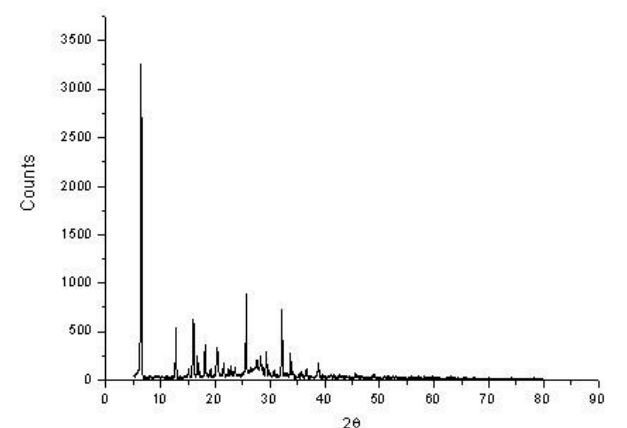
Figure 5. X-ray diffraction (XRD) of the solid NH 4 [(VO)(FA)(AA 1 )] complex.